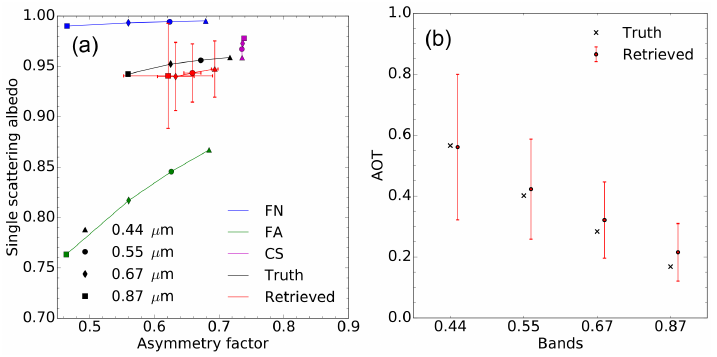
Figure 7. Same as Fig. 5 but for experiment F11.